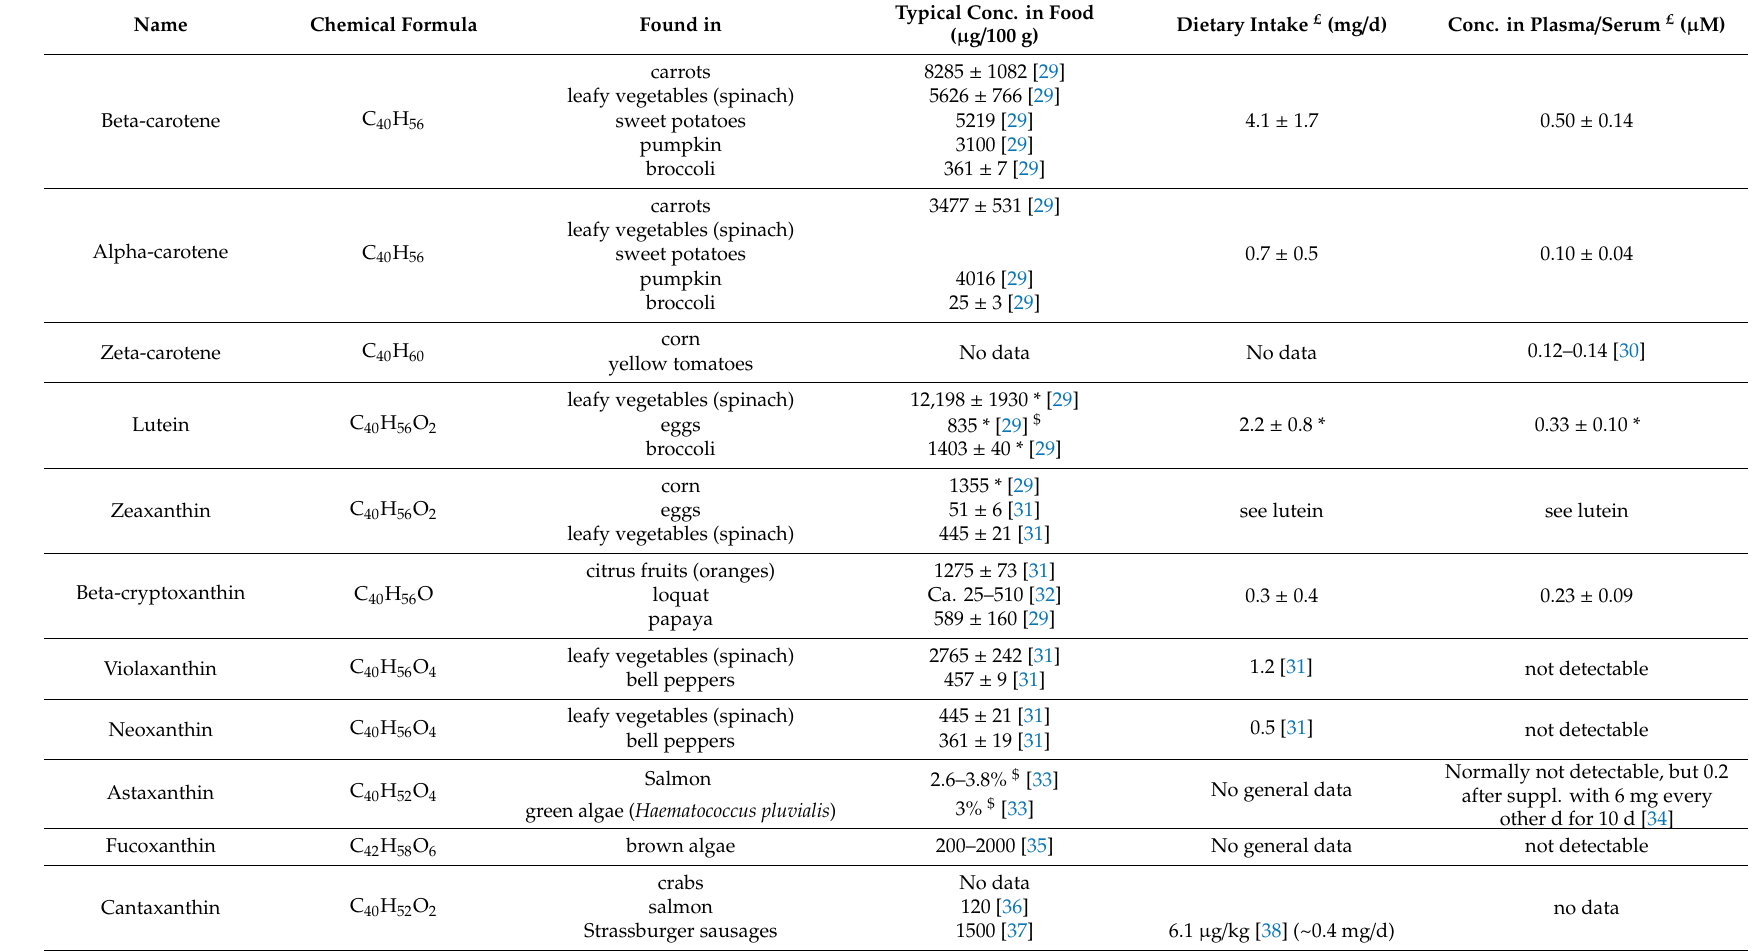
Table 1. Common carotenoids in our diet, their intake, and plasma concentrations ç